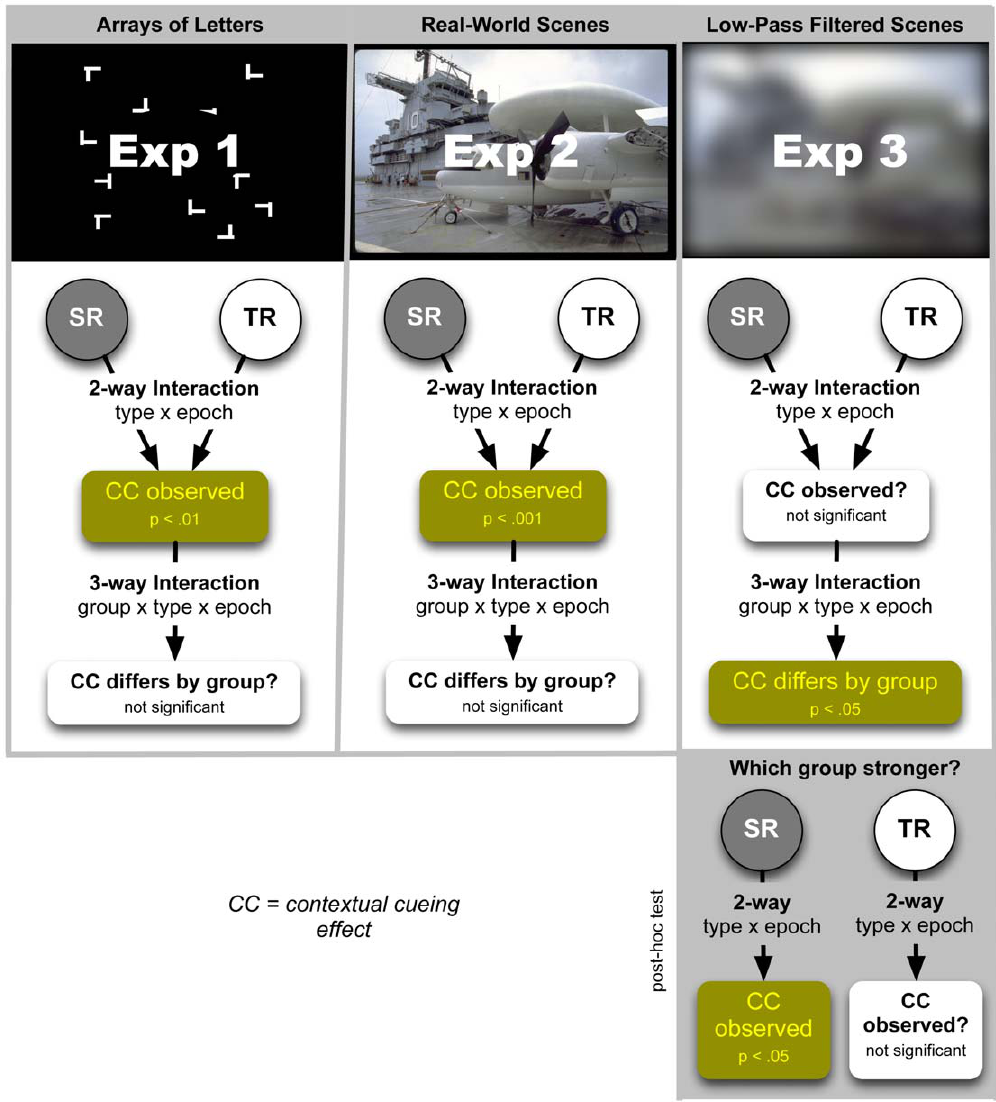
Figure 1. Schematic of experiments, analysis, and results. Contextual cueing is observed in both TR and SR groups when letter-like objects (Experiment 1) or natural scenes (Experiment 2) are used as spatial contexts. Here, the response in the two groups is indistinguishable. However, when low-pass filtered scenes are used as the spatial context (Experiment 3) a significant group interaction is observed. Further analysis reveals significant scene learning in the SR group not evident in the TR